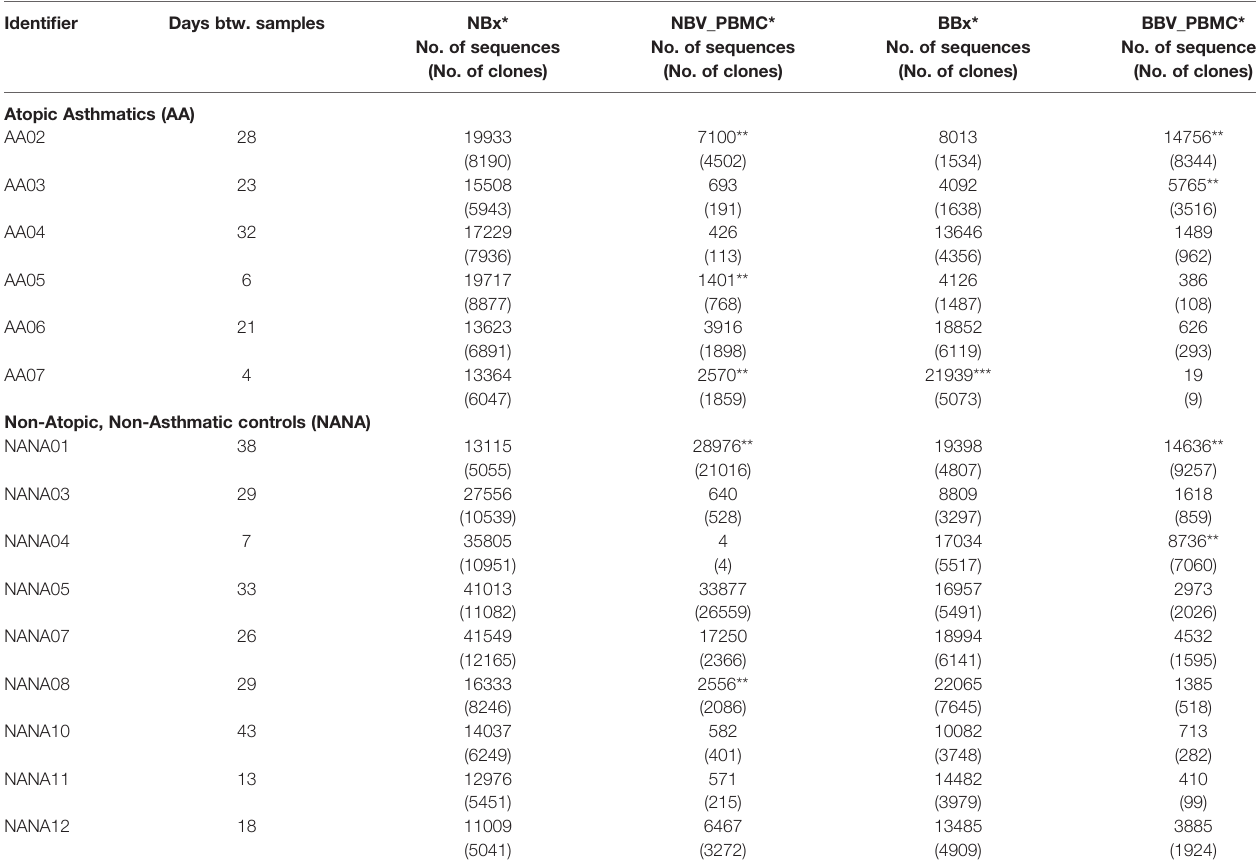
TABLE 1 | Numbers of sequences and clones from the various individuals and samples. Identi fi er Days btw.